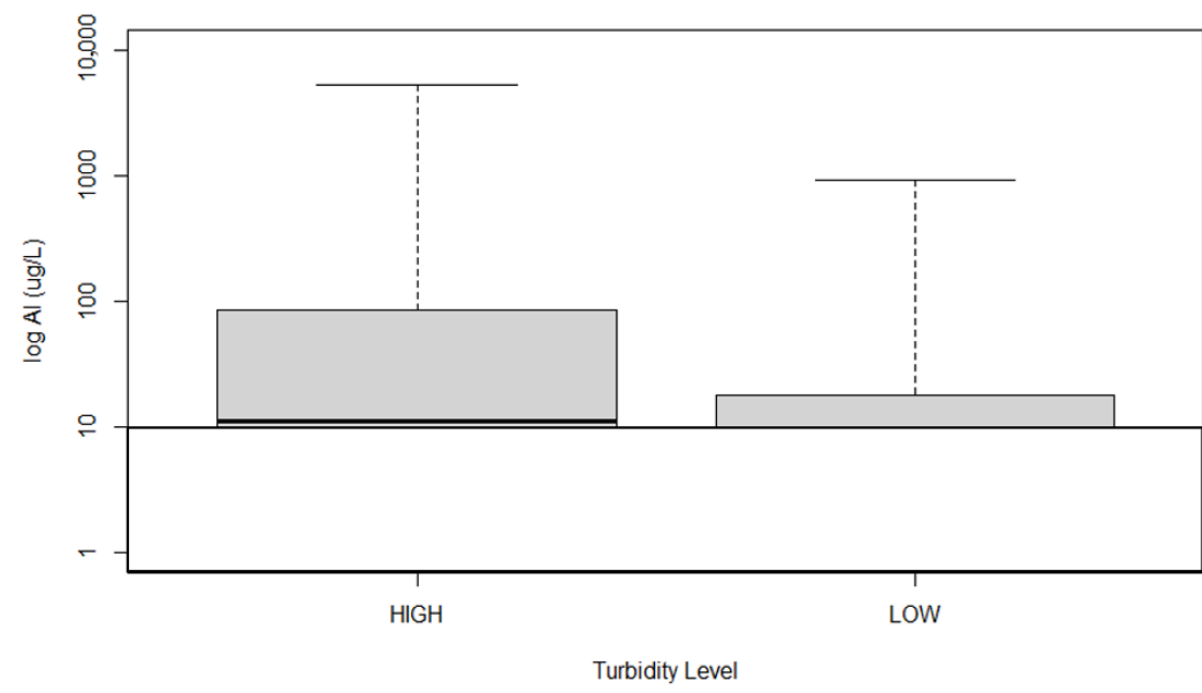
Figure 5. Censored boxplot showing difference in comparison of Al concentrations grouped by samples with high (i.e., >=5 NTU) and low (i.e., <5 NTU) turbidity. A Peto and Peto test showed this difference to be statistically significant ( p < 0.0001). Data are censored so the portion of the plot below the maximum detection limit in the dataset (e.g., 10 µg/L) is not shown.